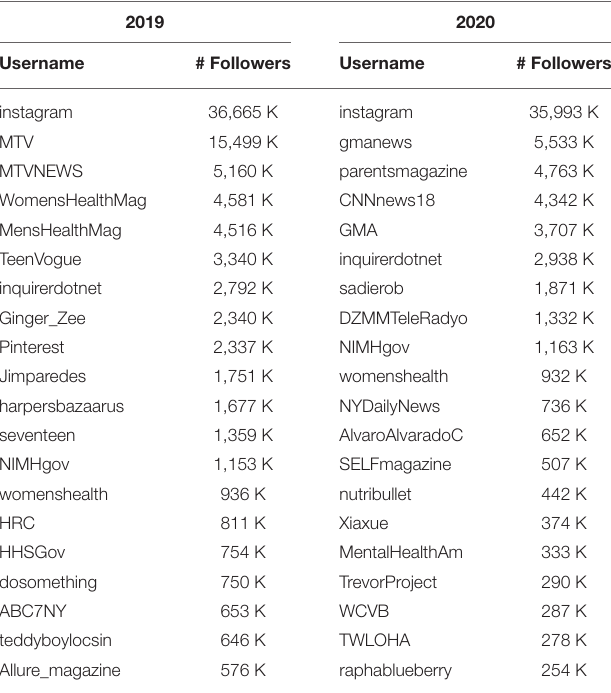
TABLE 2 | Accounts retweeting NEDAwareness content, ranked by number of followers (in thousands, K) during the campaigns of 2019 and